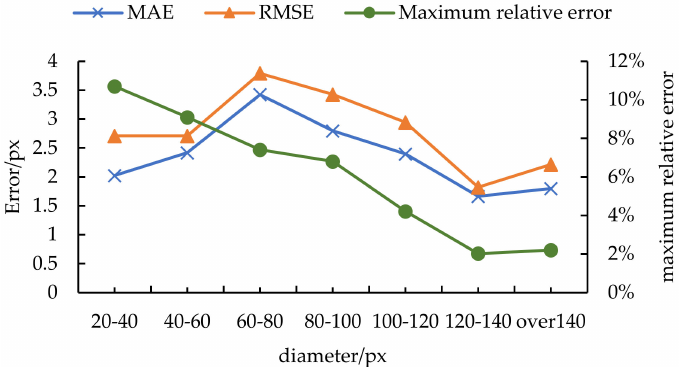
Figure 13. Analysis of fitting effects by the proposed